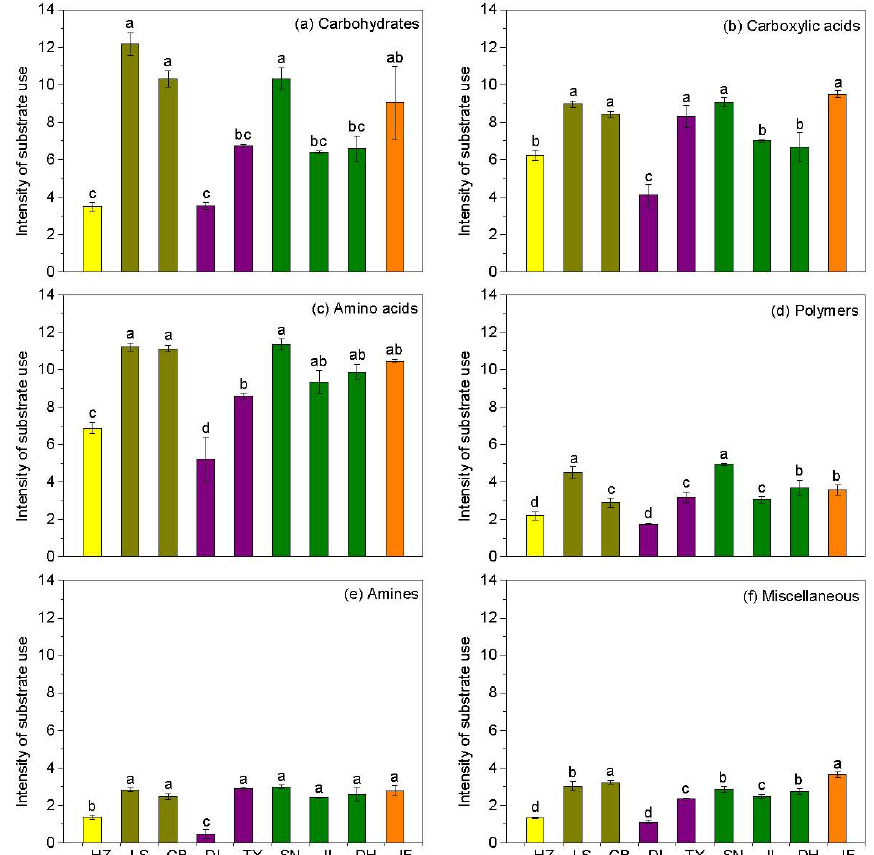
Figure 3. Characteristics of microbial use of (a) carbohydrates, (b) carboxylic acids, (c) amino acids, (d) polymers, (e) amines, and (f) mis- cellaneous along the NSTEC. The representatives of different colors are shown in Fig.